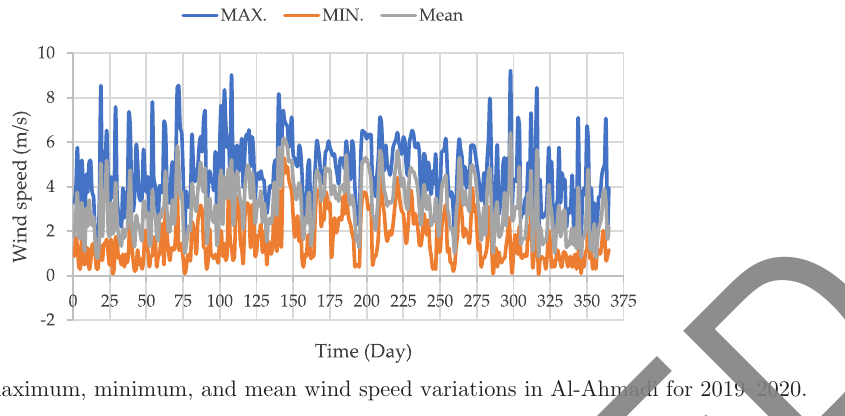
Fig. 5. Daily maximum, minimum, and mean wind speed variations in Al-Ahmadi for 2019 – 2020.